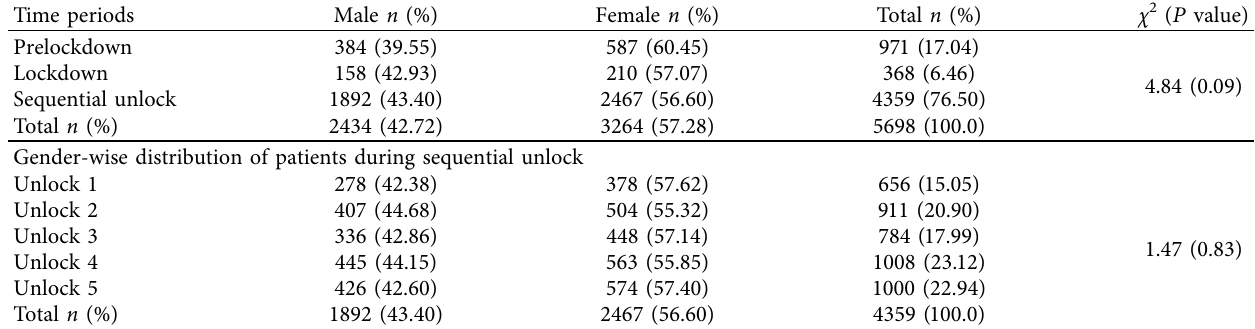
Table 1: Genderwise distribution of patients during various time periods.